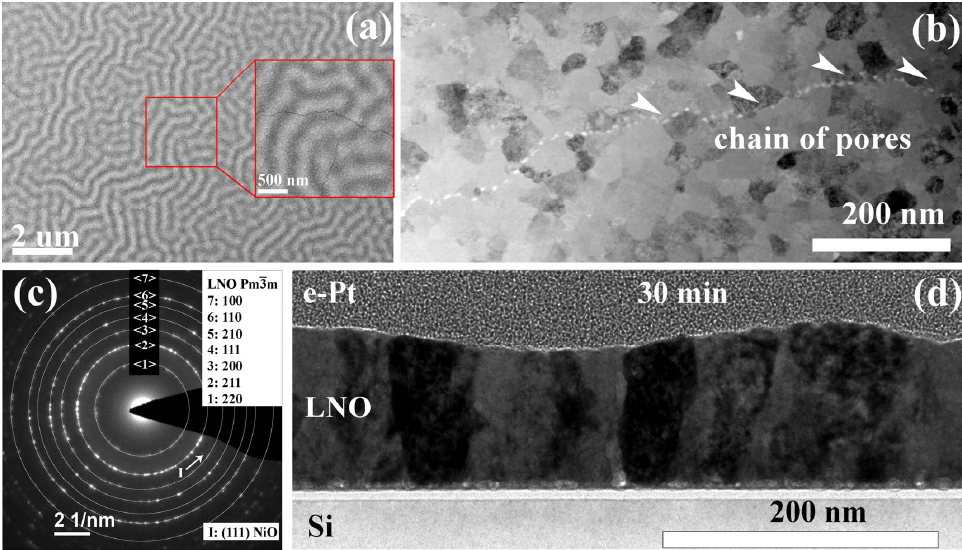
Figure 10. SEM image of the sample surface LNO-anneal-30 min ( a ); plan-view ( b ) and SAED pattern ( c ) of LNO-anneal-90 min, and BF TEM image of a cross section of LNO-anneal-30 min sample ( d ).